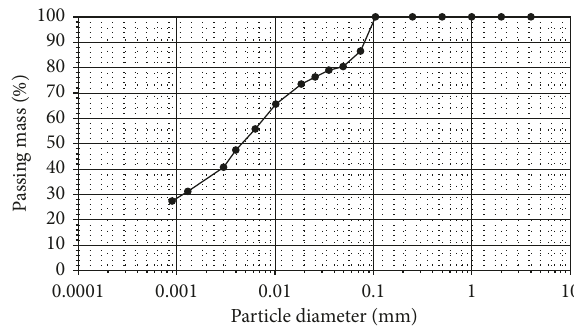
Figure 2: Grain size distribution of the adopted